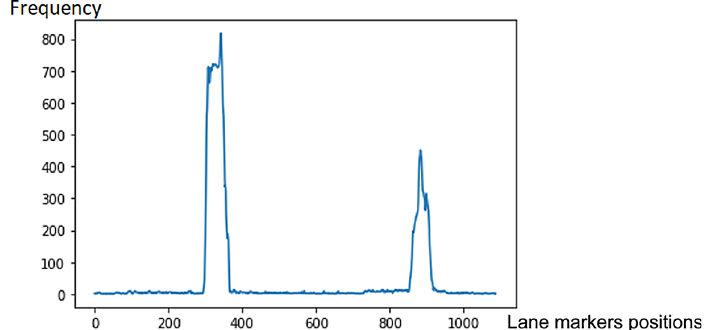
Figure 5. Detecting potential lane markers ’ locations based on histogram